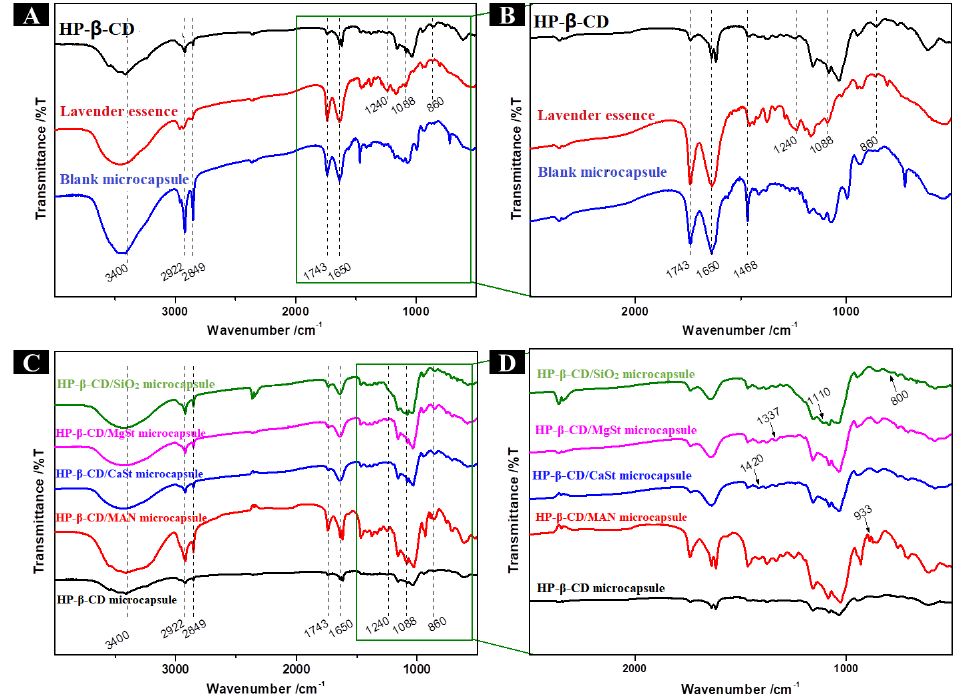
Figure 3. ( A ) FTIR spectra and ( B ) enlarged partial FTIR spectra of HP- β -CD microcapsules, blank microcapsules, and lavender essence. ( C ) FTIR spectra and ( D ) enlarged partial FTIR spectra of microcapsules with different anticaking agents.